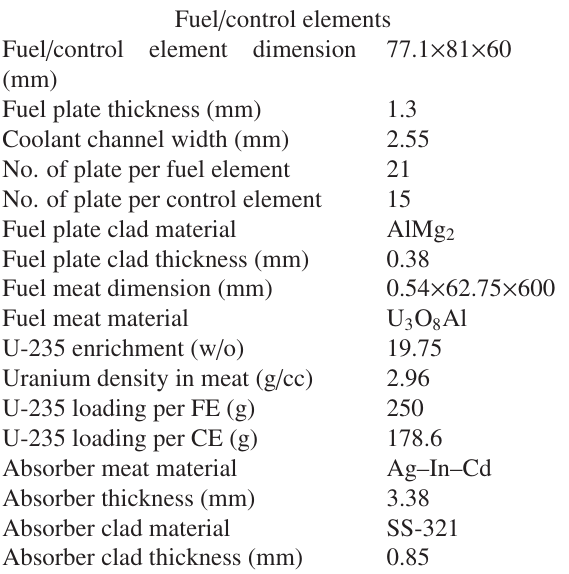
Figure 1. First criticality core configuration of RSG GAS first core [3]